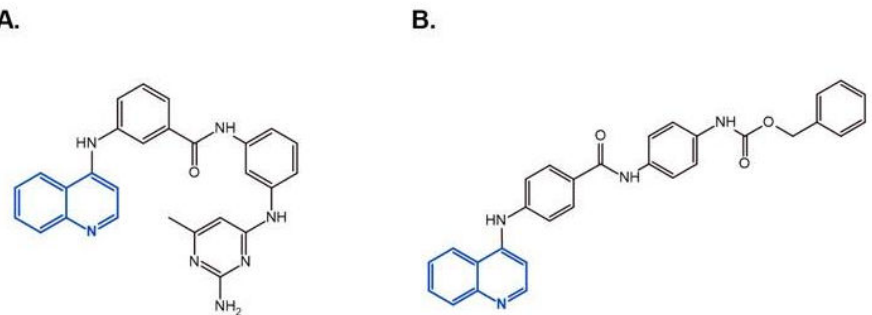
Figure 3. The chemical structures of quinoline-based DNMTis. ( A ) MC3343: one of the first non- nucleoside DNMTis tested in a cancer stem cell line. ( B ) MC3353: a novel, more potent